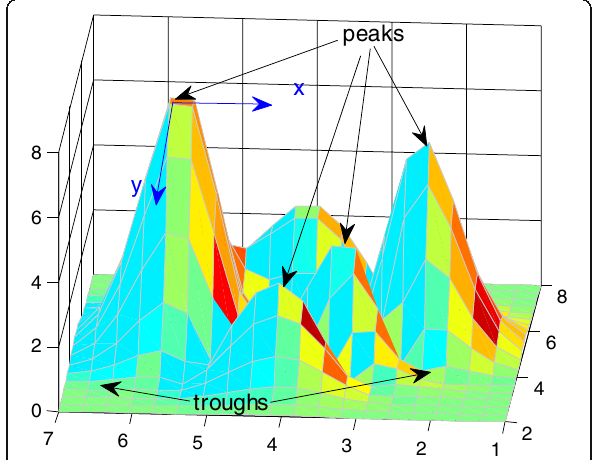
Fig. 1 The illustration of the grayscale wave model in the vertical and horizontal